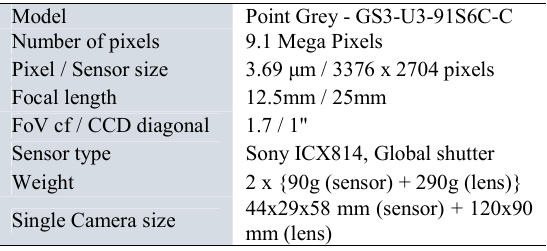
Table 1. Stereo camera technical specifications.